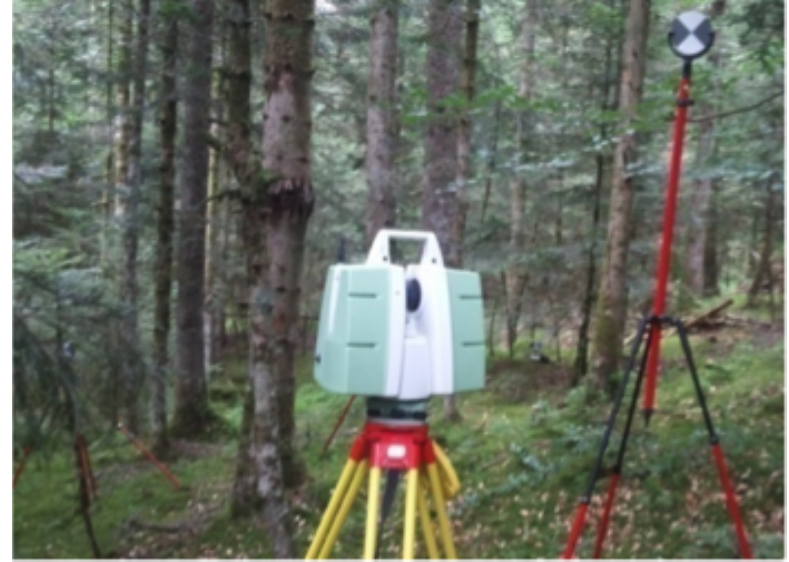
Figure 4. Leica P20 terrestrial scanning system in the forest